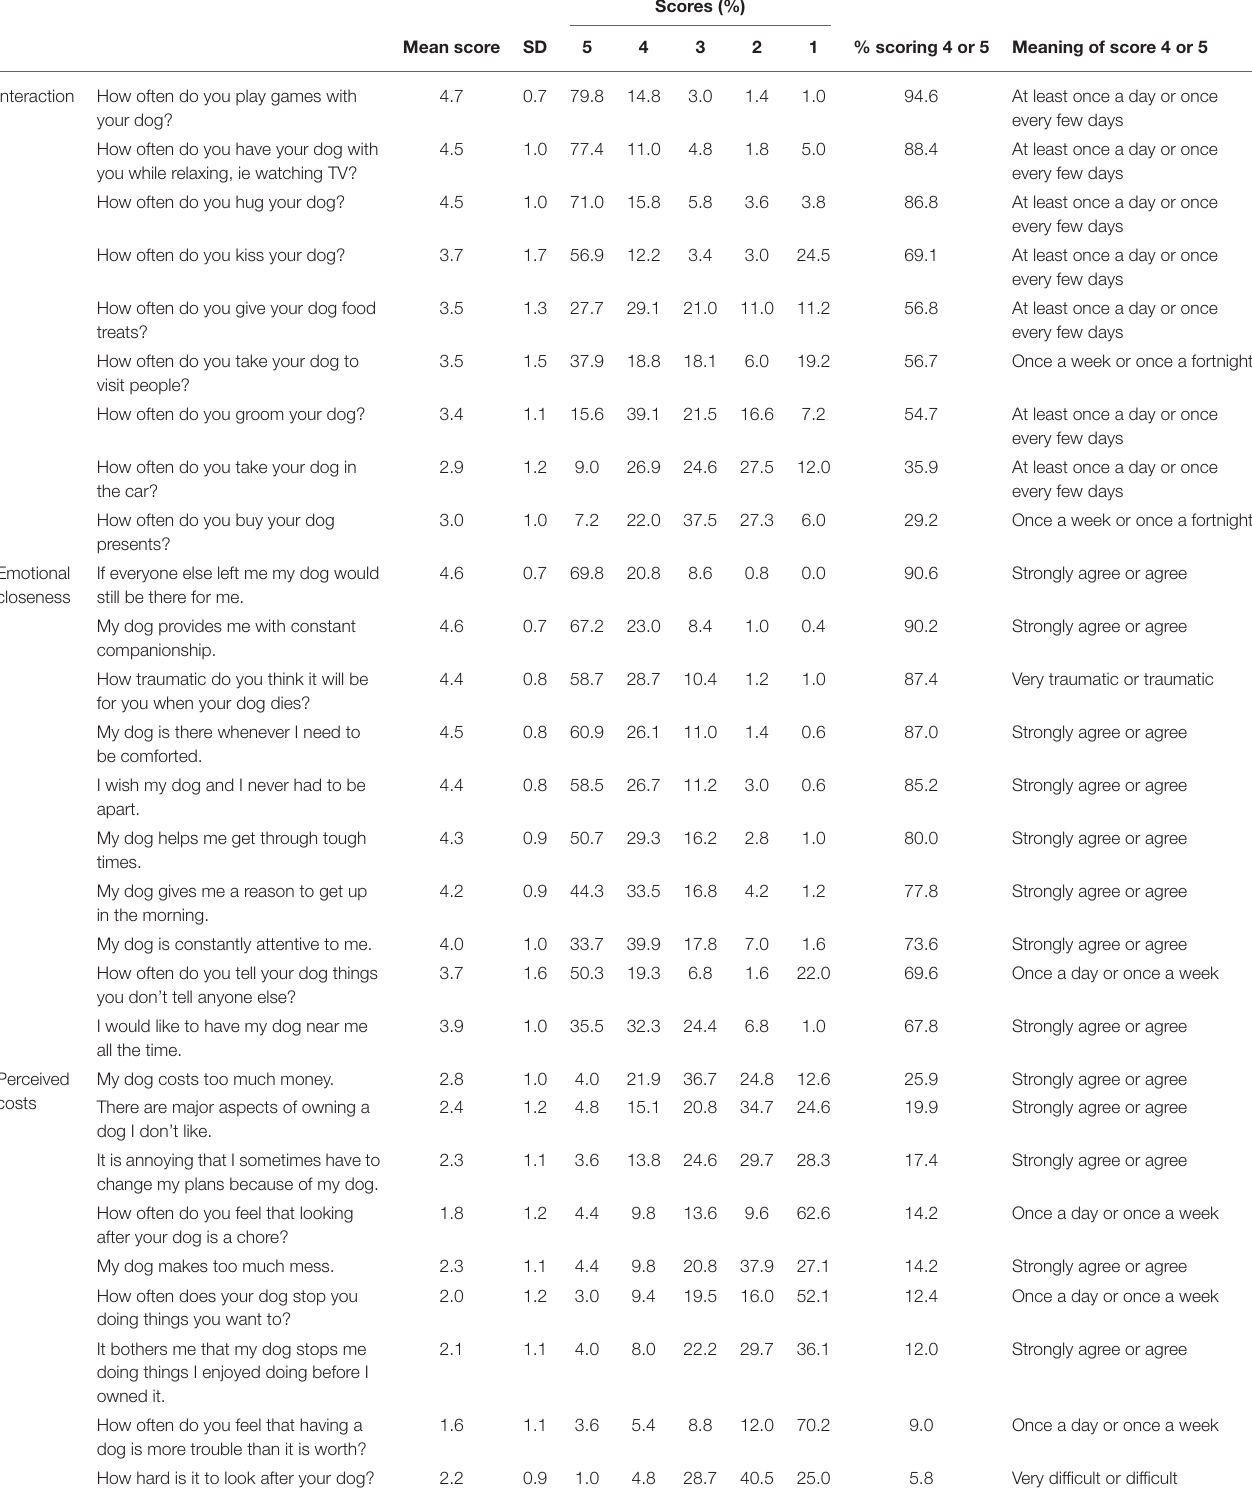
TABLE 1 | Individual item scores for MDORS items (representative